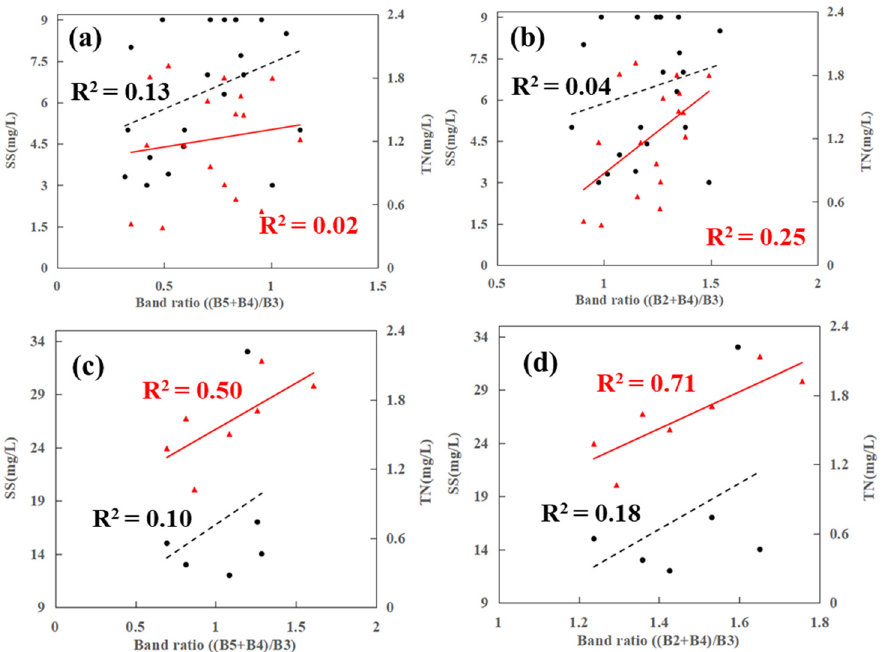
Figure 9. Correlation between suspended sediment, TN concentration and two band ratios used in statistical model. The black symbols are concentration and correlation of suspended sediment. The red symbols are concentration and correlation of TN. ( a , b ) Correlation between them in situation with suspended sediment concentration below 9 mg/L. ( c , d ) Correlation between them in situation with suspended sediment concentration above 9 mg/L.